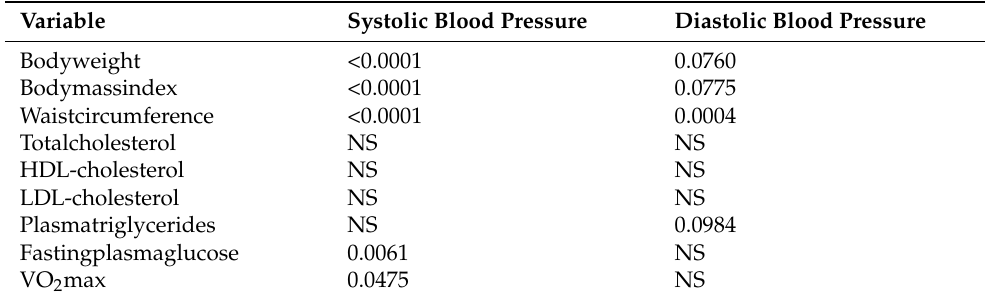
Table 2. Multivariate regression of the changes in cardiometabolic variables and changes in systolic and diastolic blood pressures ( n =